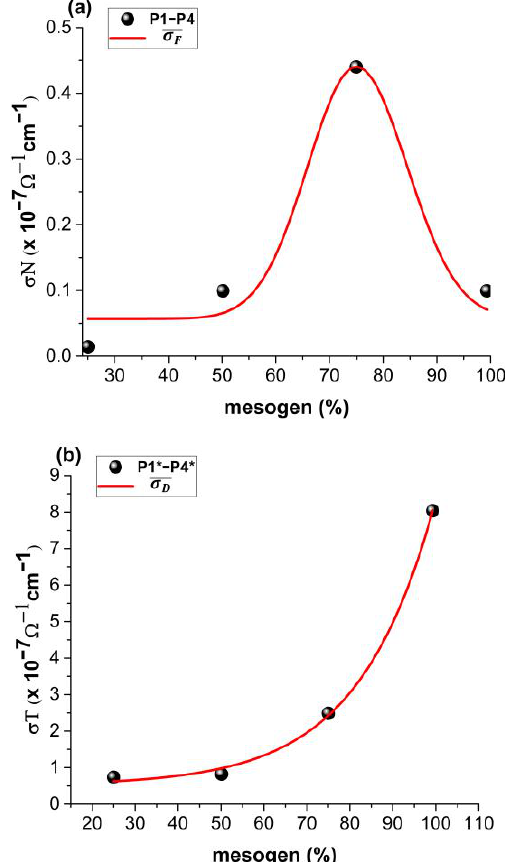
Figure 6. Calibration of the multifractal model on the untreated ( a ) and treated ( b ) polymers .